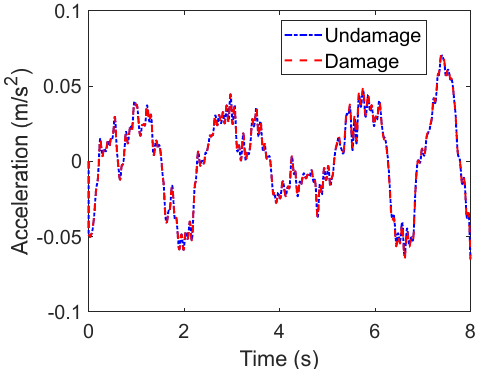
Figure 8. Accelerations for different bridge conditions.